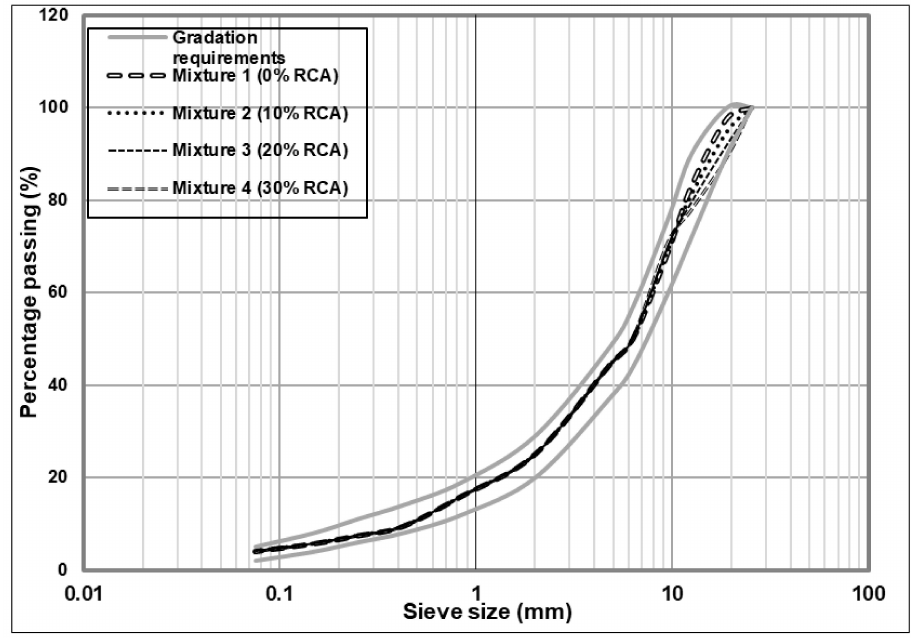
Figure 3. Granulometric curve of the petrous mixtures.